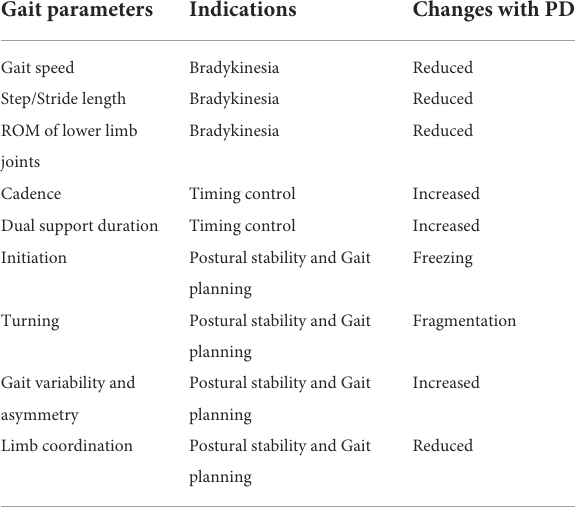
TABLE 1 Typical gait parameters and impairments for